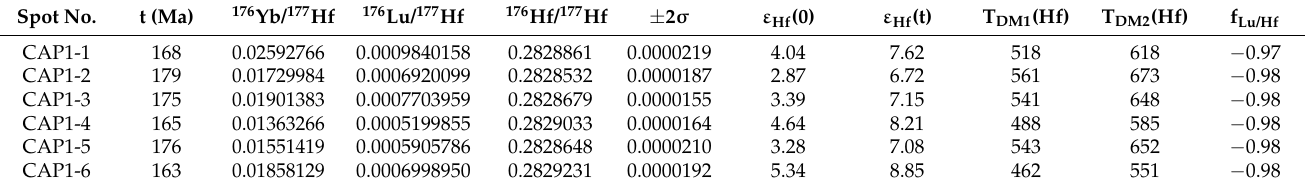
Table 4. Zircon Hf isotopic compositions for monzogranite in the Chang’anpu Mo deposit.